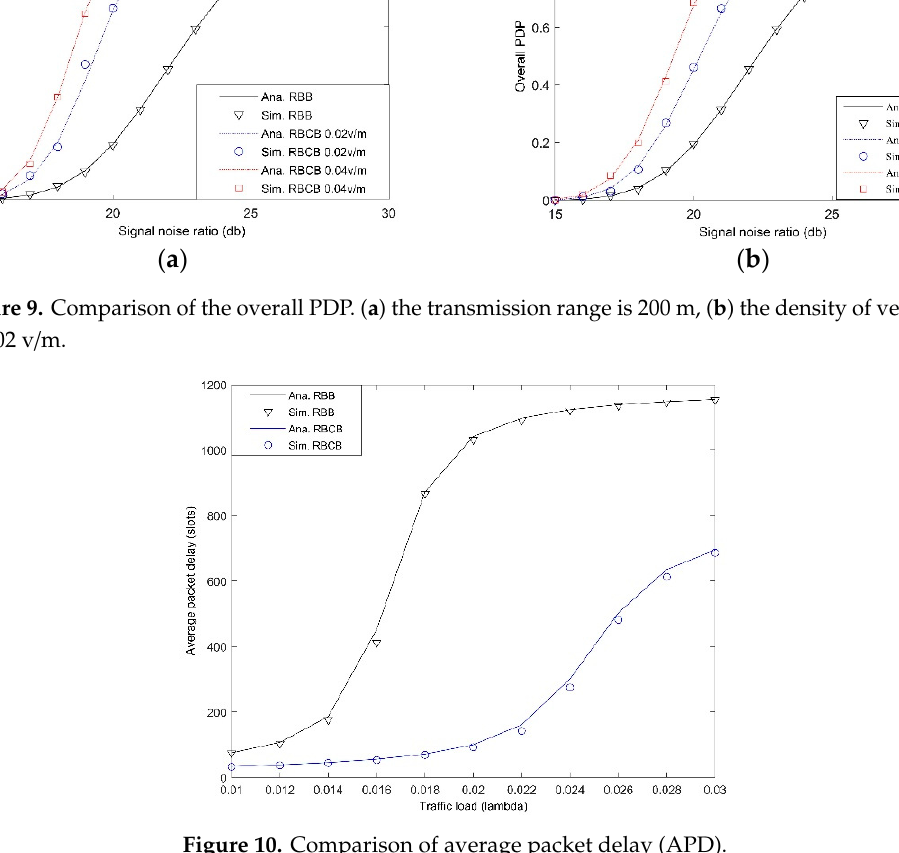
Figure 11. Comparison of success probability.